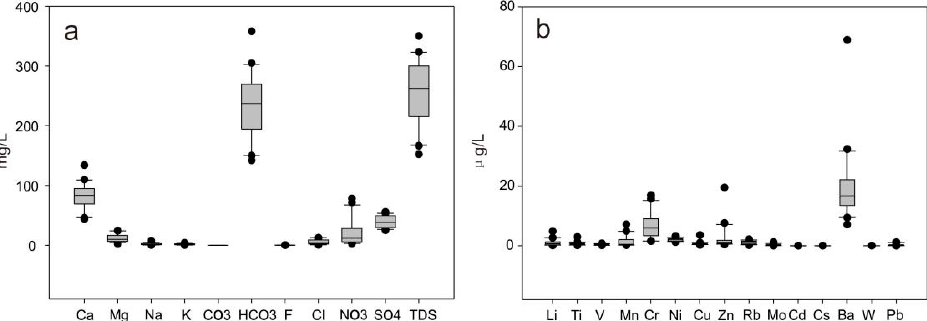
Figure 5. ( a ) Geochemical characteristics of major ions and ( b ) trace elements of shallow groundwater based on boxplot